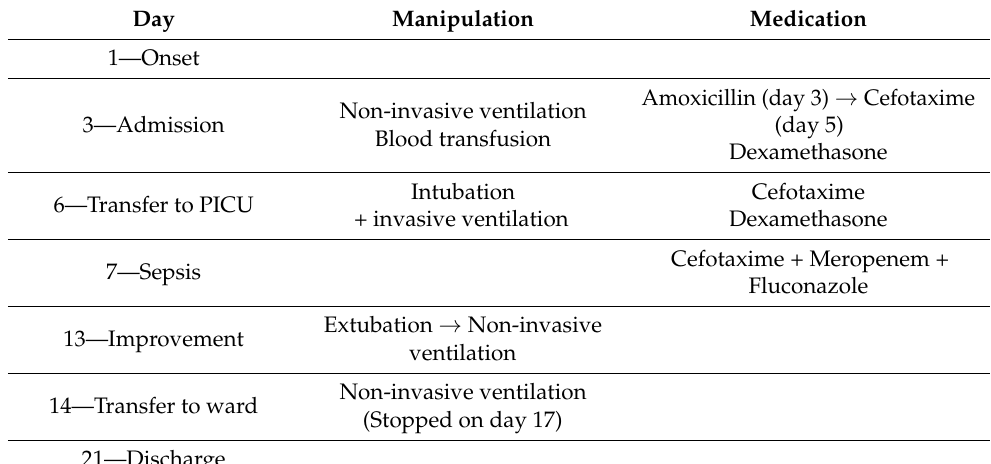
Table 1. Manipulations and key medications administered throughout the hospitalization period.